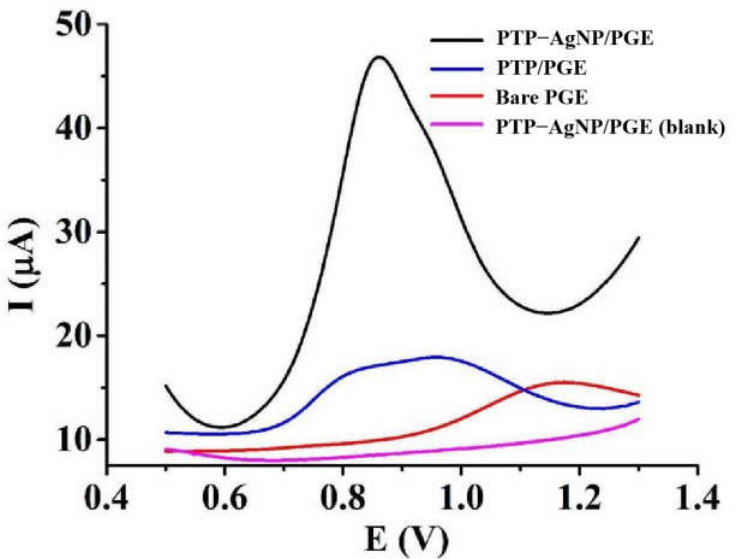
Figure 5. Differential pulse voltammograms between 0 mM and 2 mM of nitrite on different electrodes in 0.1 M PB (pH = 4.0).